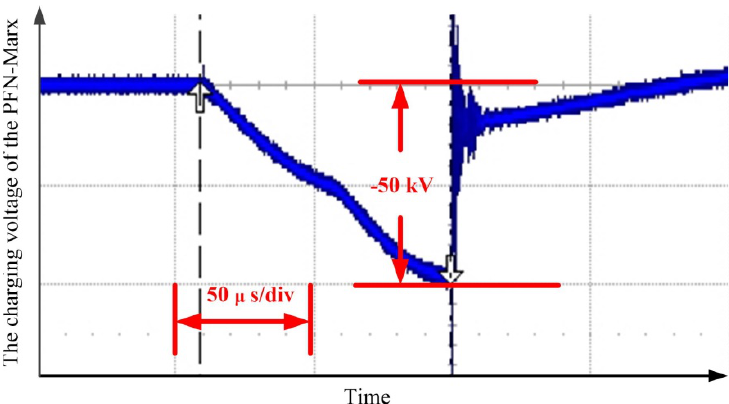
Figure 9. The charging voltage waveform of the PFN-Marx generator.